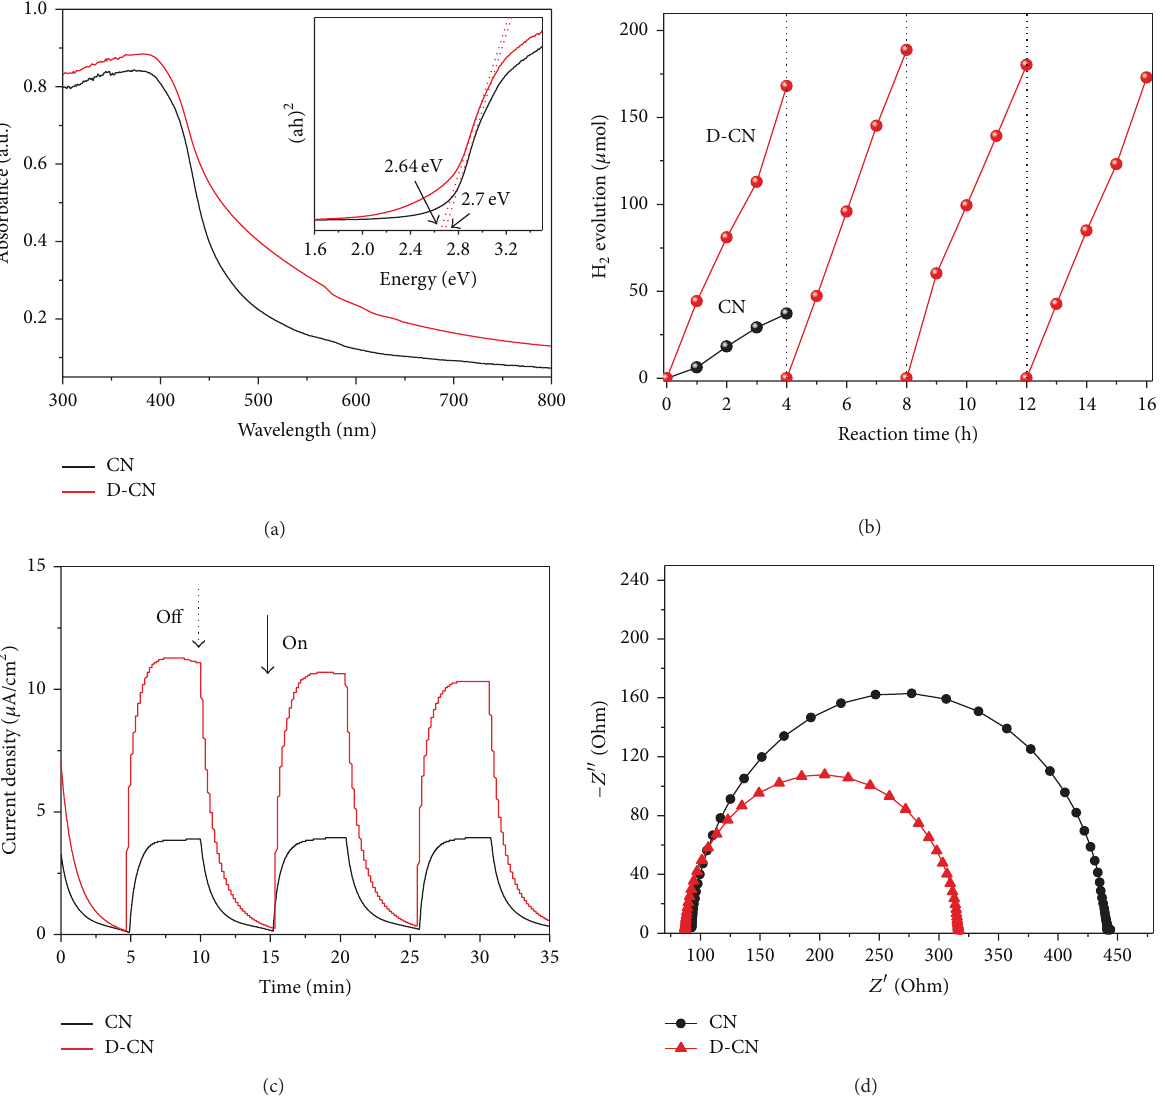
Figure 4: (a) UV-vis absorption spectra of the CN and D-CN samples. (b) Stability test of 3.0 wt% Pt-deposited D-CN (50mg) for H 2 production in aqueous triethanolamine solution (10vol%) under visible light and CN sample is also shown for comparison. (c) Transient photocurrent generation from CN and D-CN electrodes at 0.6 V versus Ag/AgCl in 0.2 M Na 2 SO 4 under simulated sunlight irradiation. (d) EIS Nyquist plots of CN and